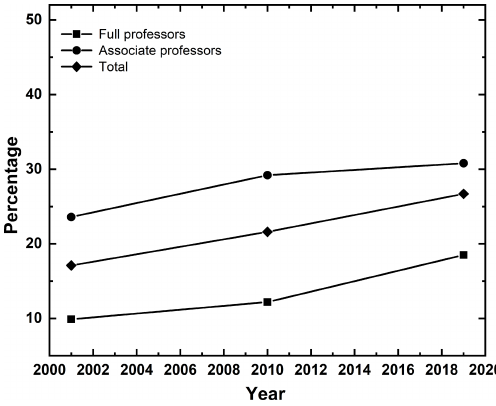
Figure 3. Percentages of female full and associate professors in geosciences in Italy relative to 2001–2019 time span (data source: MIUR, https://cercauniversita.cineca.it/php5/docenti/cerca. php, last access: 31 October